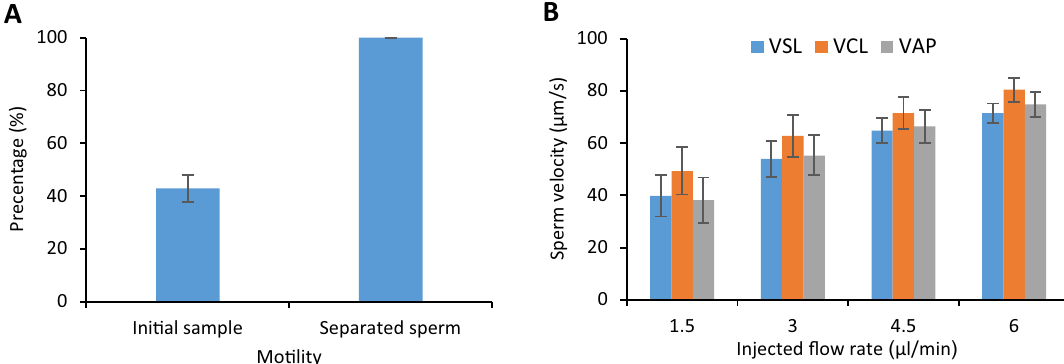
Figure 6. Separated human sperm quality analysis using CASA. ( A ) Separated sperm motility compared with the motility of the initial sample. ( B ) Velocity parameters of the separated sperm, including VAP, VCL, and VSL, for different flow rates. Values are reported as mean ± s.d (n ≥ 20, n: the number of single sperm cells